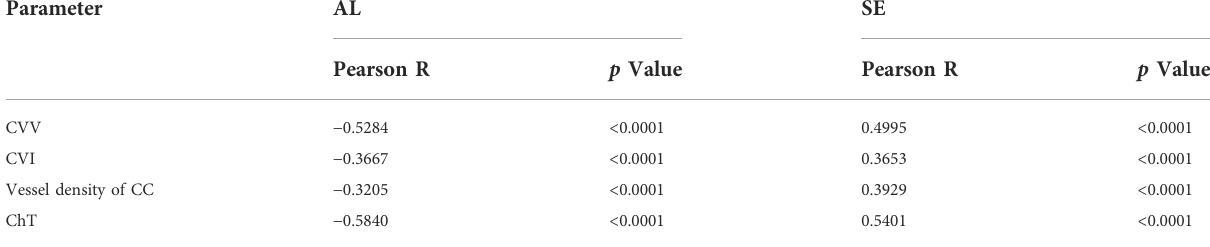
TABLE 3 Correlation of choroidal parameters with AL and